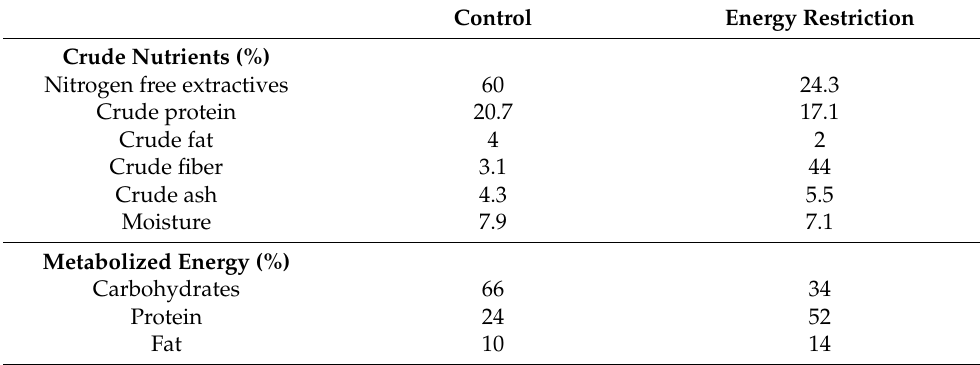
Table 1. Analytical composition of the two diets used in the